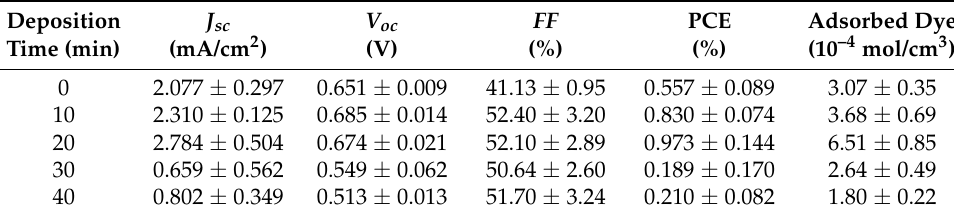
Figure 4. Photovoltaic performance variations with deposition period of silver ions: ( a ) J sc , ( b ) V oc , ( c ) FF , and ( d ) PCE of the DSCs with 8 h-grown ZnO nanorods. J sc , V oc , and FF are measured under AM 1.5 illumination. Table 3. Photovoltaic parameters and dye-loading amounts of DSCs with deposition time of silver ions on 8 h-grown ZnO nanorods.